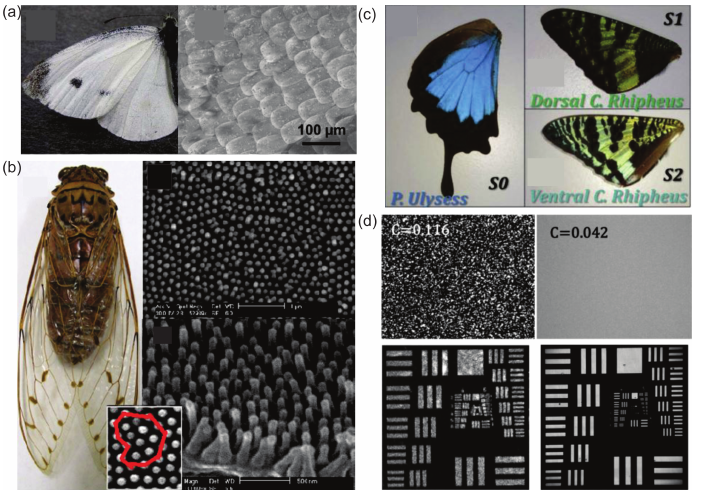
Figure 5. Bio-compatible RLs. ( a ) Picture of a Pieris canidia butterfly and its low magnification SEM image of the wing. Adapted from Ref. [22] with permission from Springer Nature under CC BY-NC-ND 4.0 license. ( b ) Picture of the pomponia imperatoria cicada and its different magnification SEM images of the wing. Adapted from Ref. [23] with permission from Elsevier B.V. ( c ) Pictures of a lower wing of P. Ulysses (S0), an upper dorsal wing of C. rhipheus (S1) and an upper ventral wing of C. rhipheus (S2). ( d ) Scattering images of a Q-switched Nd:YAG laser with 532 nm wavelength (upper left) and RL of S1 (upper right) without imaging object. The lower row shows the images of 1951 US AF resolution test chart illustrated by a Q-switched Nd:YAG laser with 532 nm wavelength (lower left) and by the RL of S1 (lower right). Adapted from Ref. [24] with permission from Optical Society of